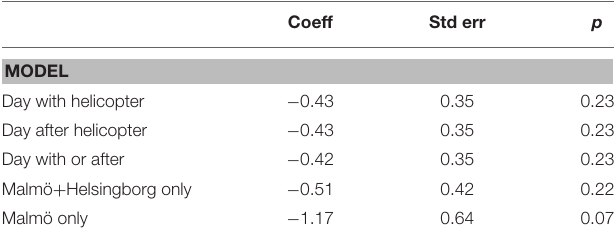
TABLE 2 | Negative binomial regression coefficients for the association of helicopter patrolling with vehicle